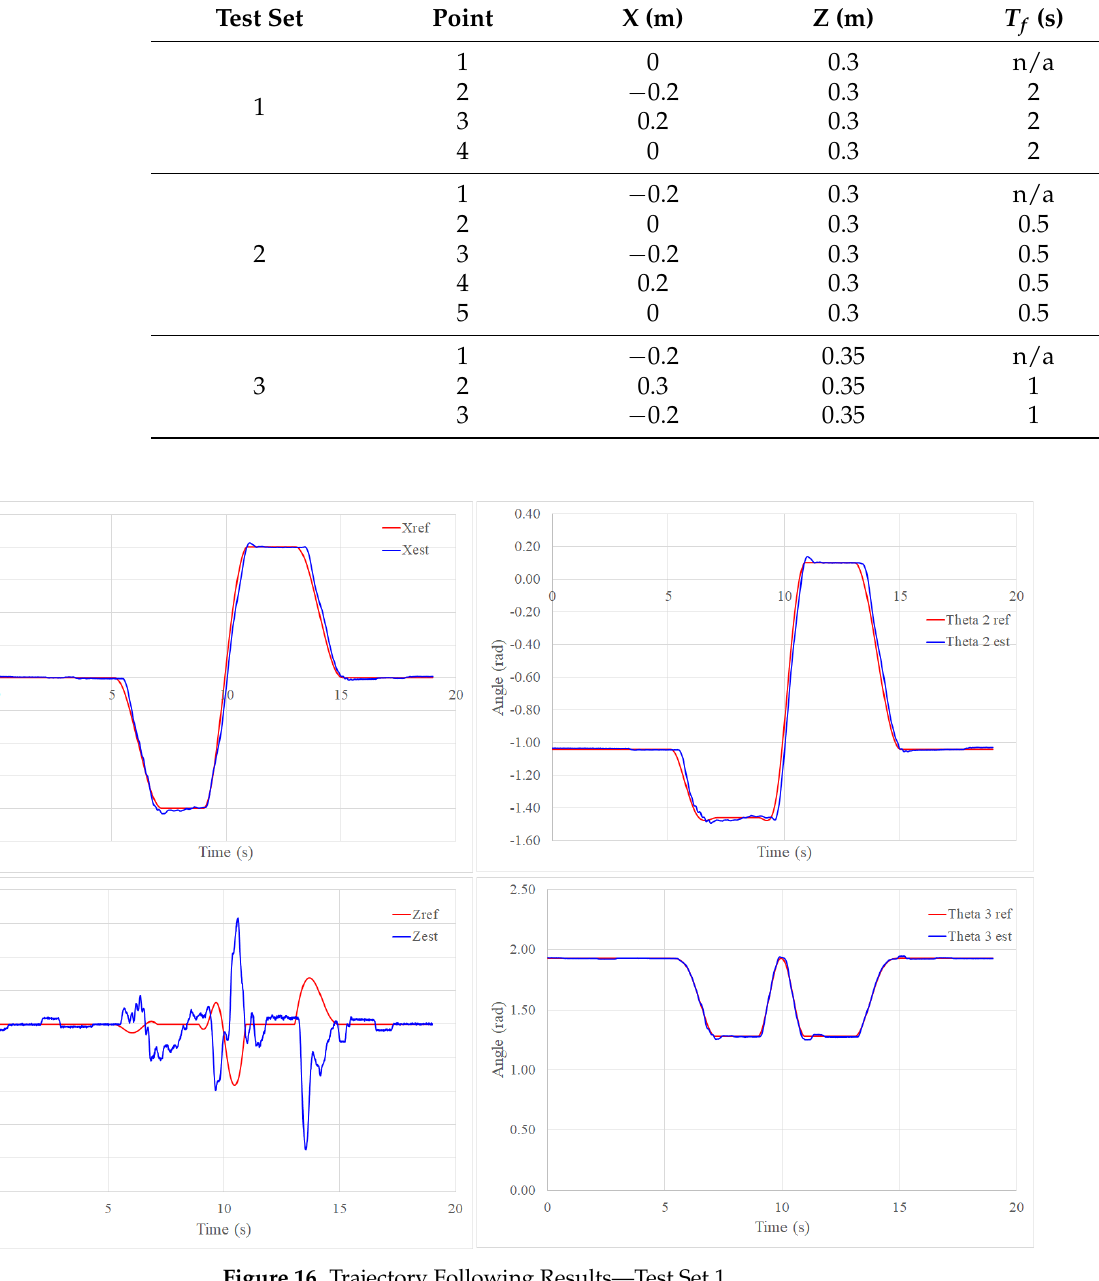
Figure 16. Trajectory Following Results—Test Set